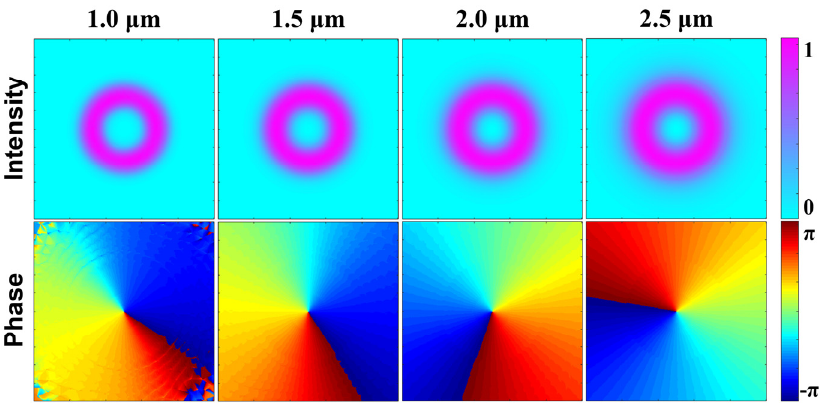
Figure 4. Normalized intensity and phase distributions at different wavelengths of OAM 1,1 mode supported in the designed RCF.